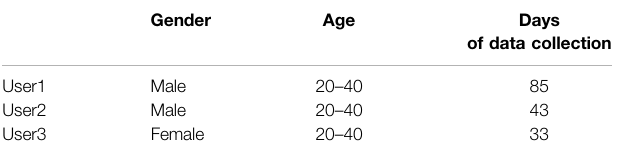
TABLE 2 | Three users in the complete SHL datasets.